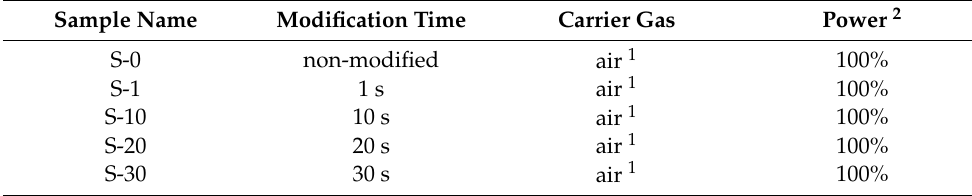
Table 1. Parameters of the plasma activation of the